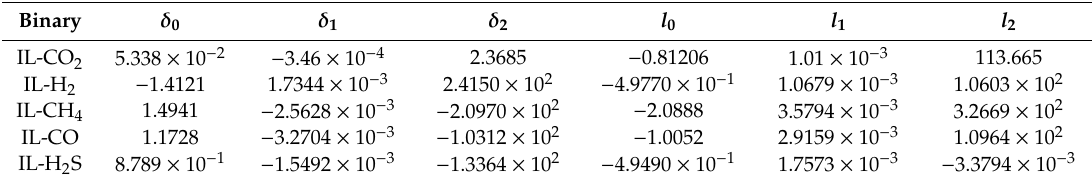
Table 4. Binary parameter interactions for the [hmim][Hf 2 N] ionic liquid according to Equations (15) and (17).